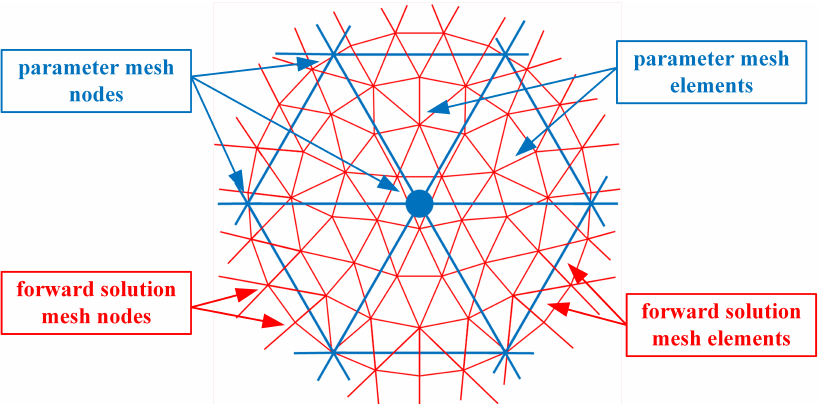
Figure 1. Overlapping forward solution and parameter meshes corresponding to the nodes and